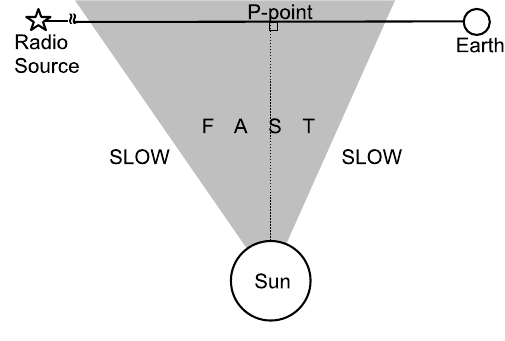
Fig. 3. A diagram illustrating the IPS line of sight as viewed from above. The point of closest approach of the line of sight to the Sun is indicated as the P-point. Example locations of fast and slow streams are